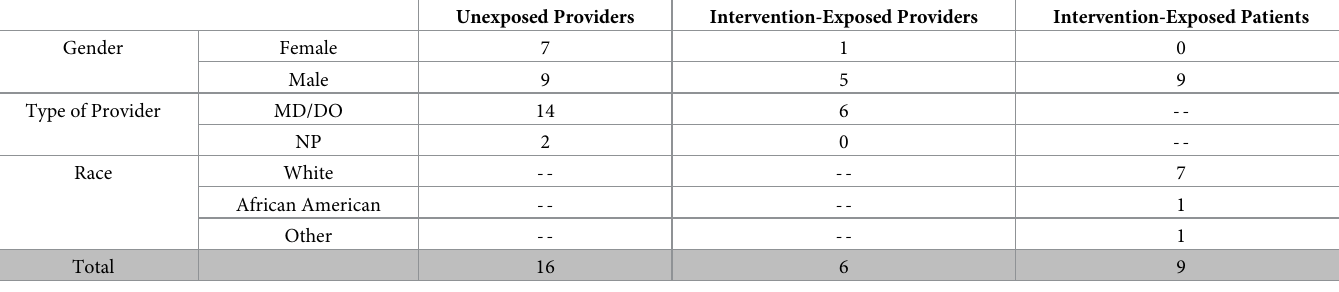
Table 1. Demographics of study participants interviewed. Unexposed Providers Intervention-Exposed Providers Intervention-Exposed